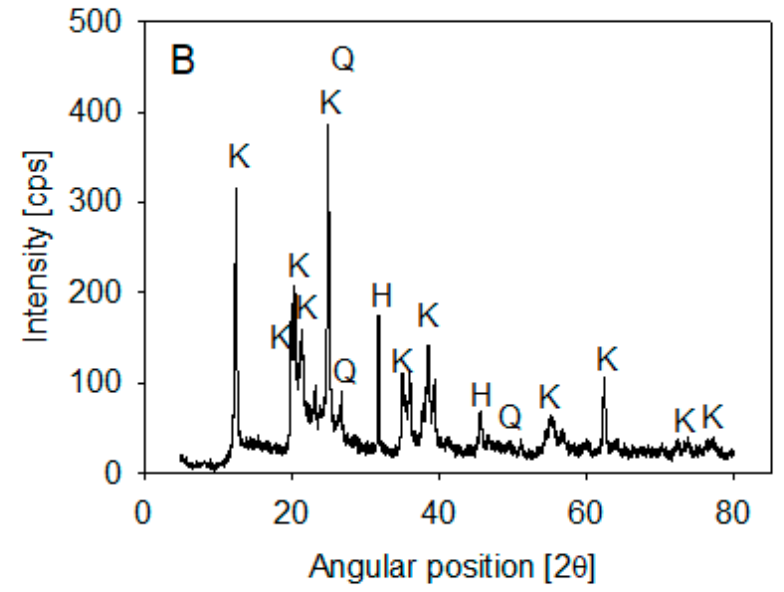
Figure 1. XRD of kaolin